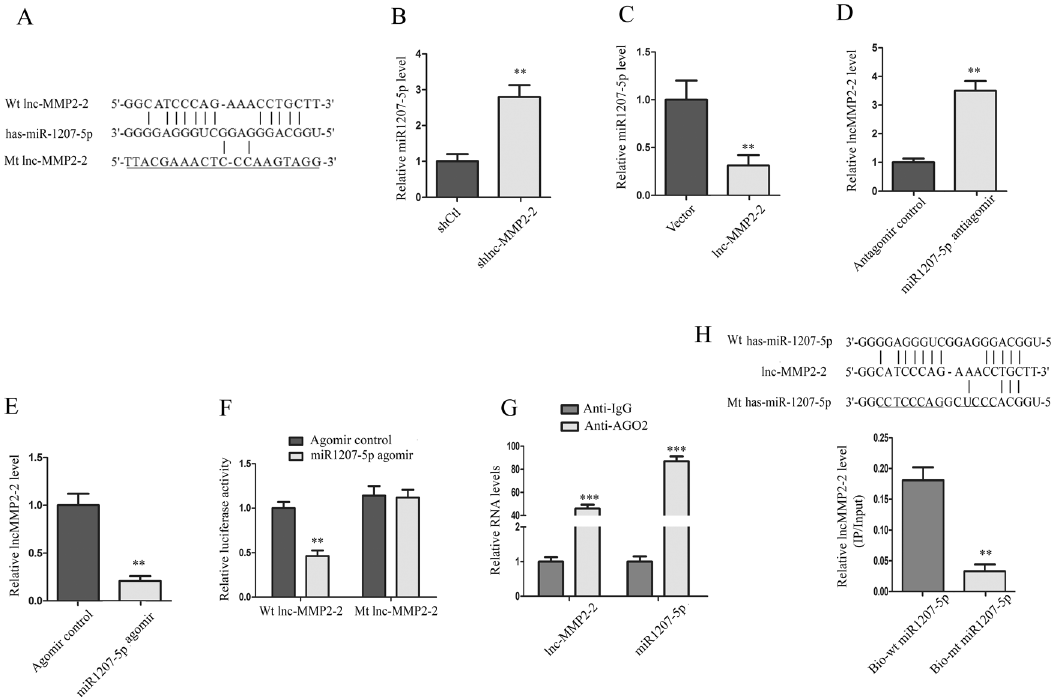
Fig. 4 lnc-MMP2-2 functions as molecular sponge for miR-1207-5p in HBMECs. A The potential binding sites between miR-1207-5p and lnc- MMP2-2. B , C Stable lnc-MMP2-2-knocked down or -overexpressed HBMEC are subjected to qRT-PCR for analysis of miR-1207-5p expression. D , E lnc-MMP2-2 expression is decreased after transfection with miR-1207-5p inhibitor or agomir. F Complementary sequence between miR- 1207-5p and wild-type (Wt) lnc-MMP2-2. The putative binding sites of miR-1207-5p is mutated in lnc-MMP2-2 (Mt lnc-MMP2-2). Luciferase activity is measured in HBMECs that are co-transfected with miR-1207-5p agomir and Wt or Mt lnc-MMP2-2 vector. G Anti-Ago2 RIP is performed in HBMECs transiently overexpressing miR-1207-5p. H The sequences for Wt and Mt forms of miR-1207-5p are shown. lnc-MMP2-2 is highly enriched in the sample pulled down by biotinylated Wt miR-1207-5p but not in Mt miR-1207-5p. ** p < 0.01, *** p < 0.001.